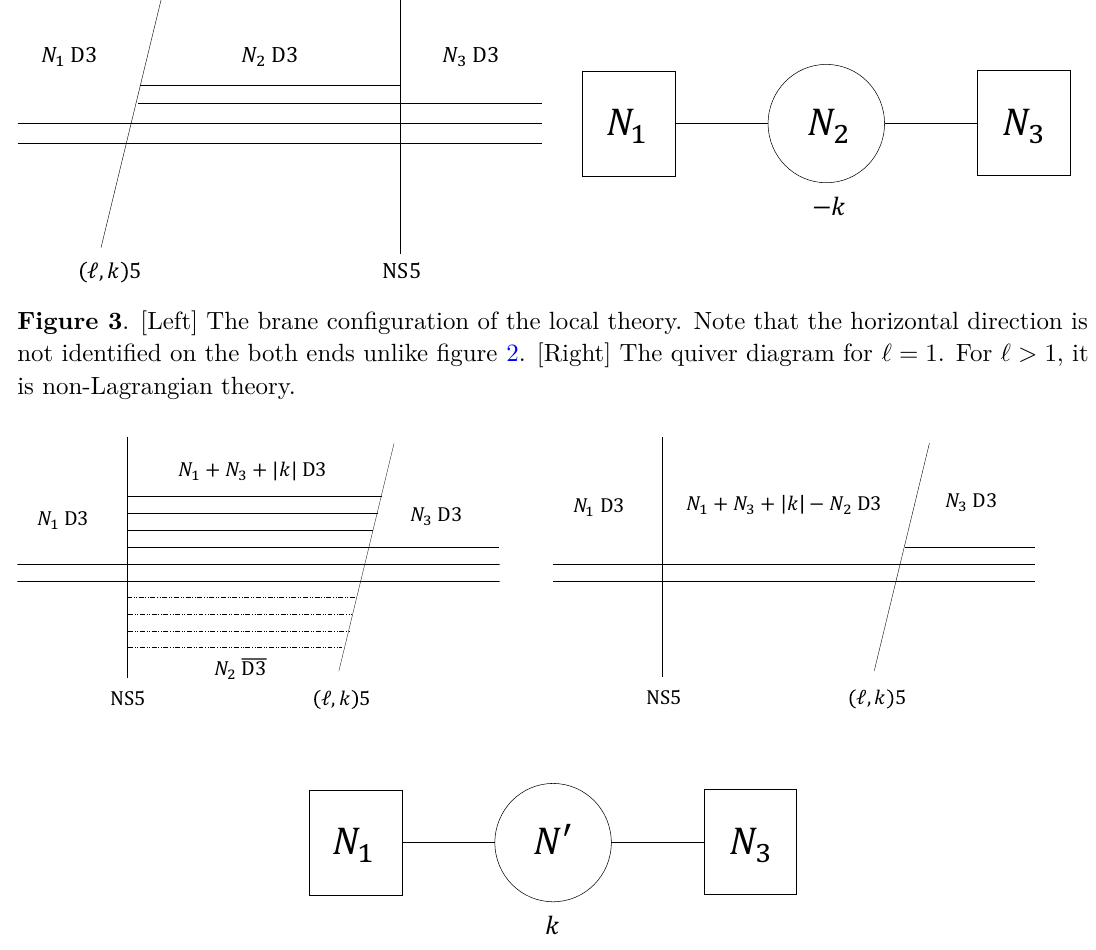
Figure 4 . An illustration of The Hanany-Witten move for the local theory ( N 1 = 2 , N 2 = 4 , N 3 = 3 , k = 1 in this figure). [Left] N 2 D3-branes become anti-D3-branes (dotted lines) and | k | D3-branes are created. [Right] The N pairs of D3 and anti-D3-branes are annihilated. 2